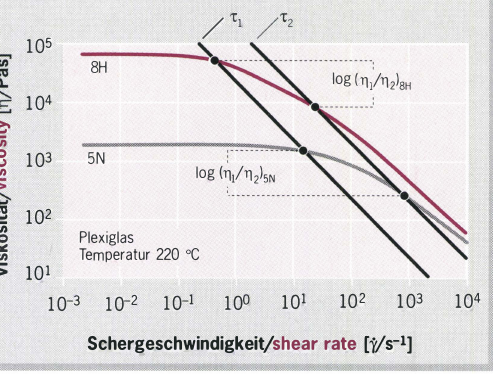
Fig. 4: Reference viscosity functions 11 • and 11 • MVI for LD polyethylene at different